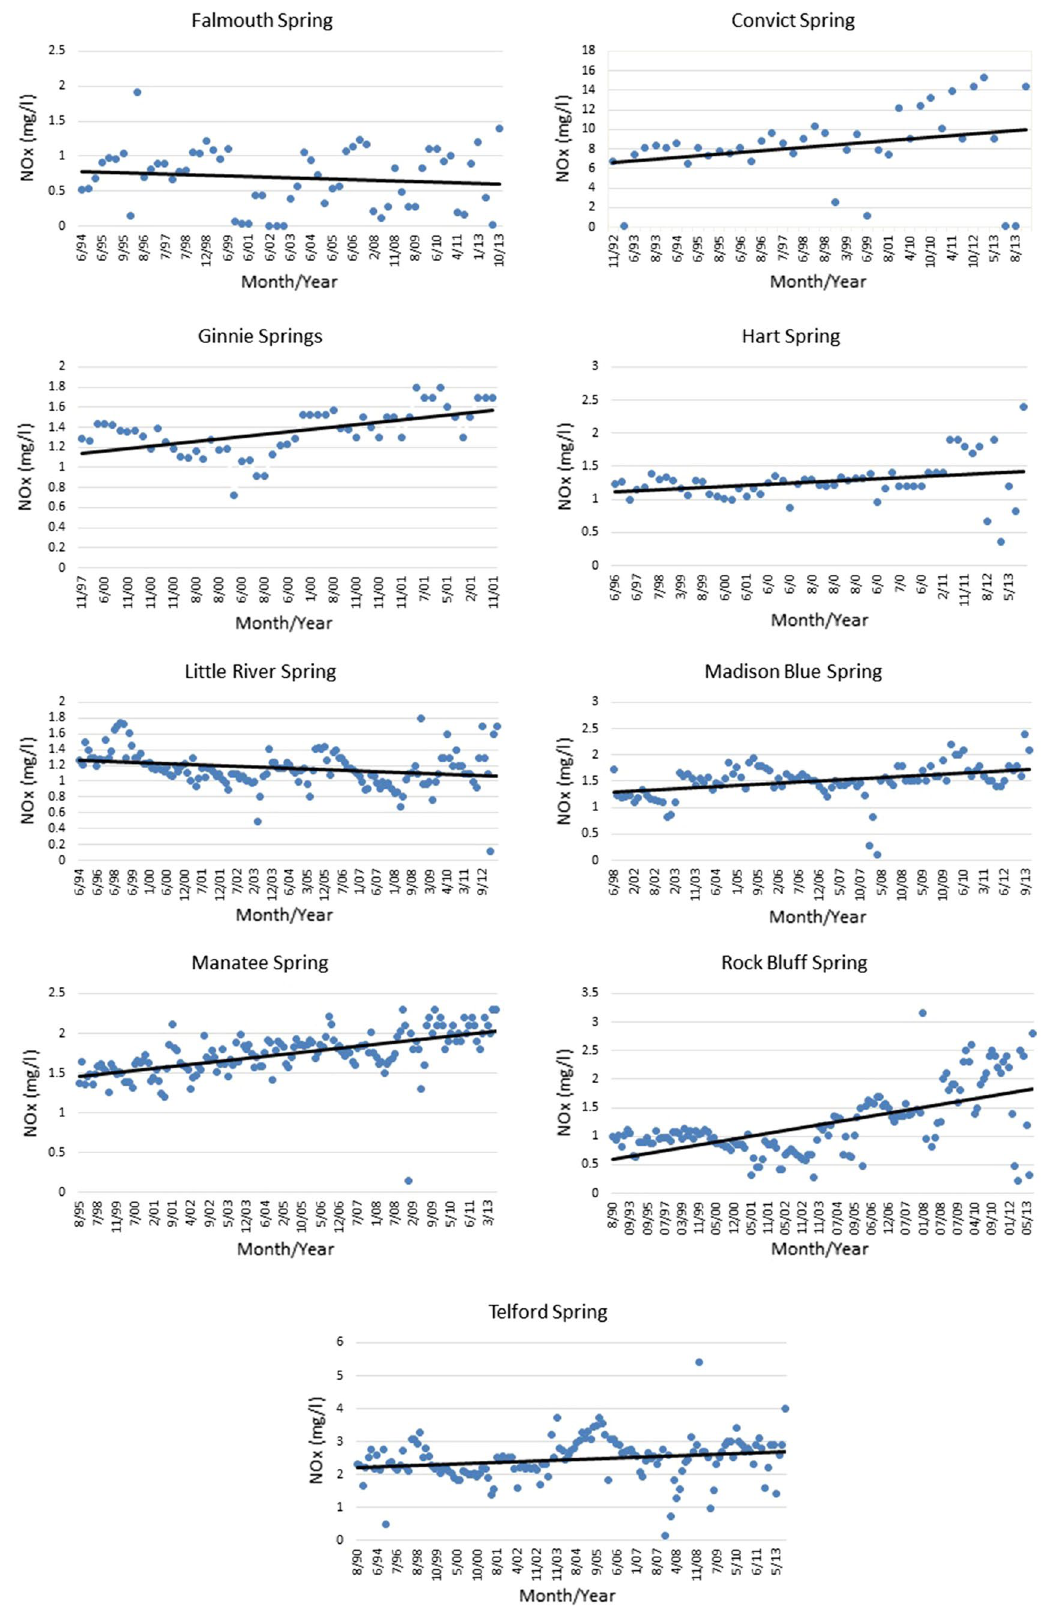
Fig. 6 Total nitrate concentration changes in time for selected